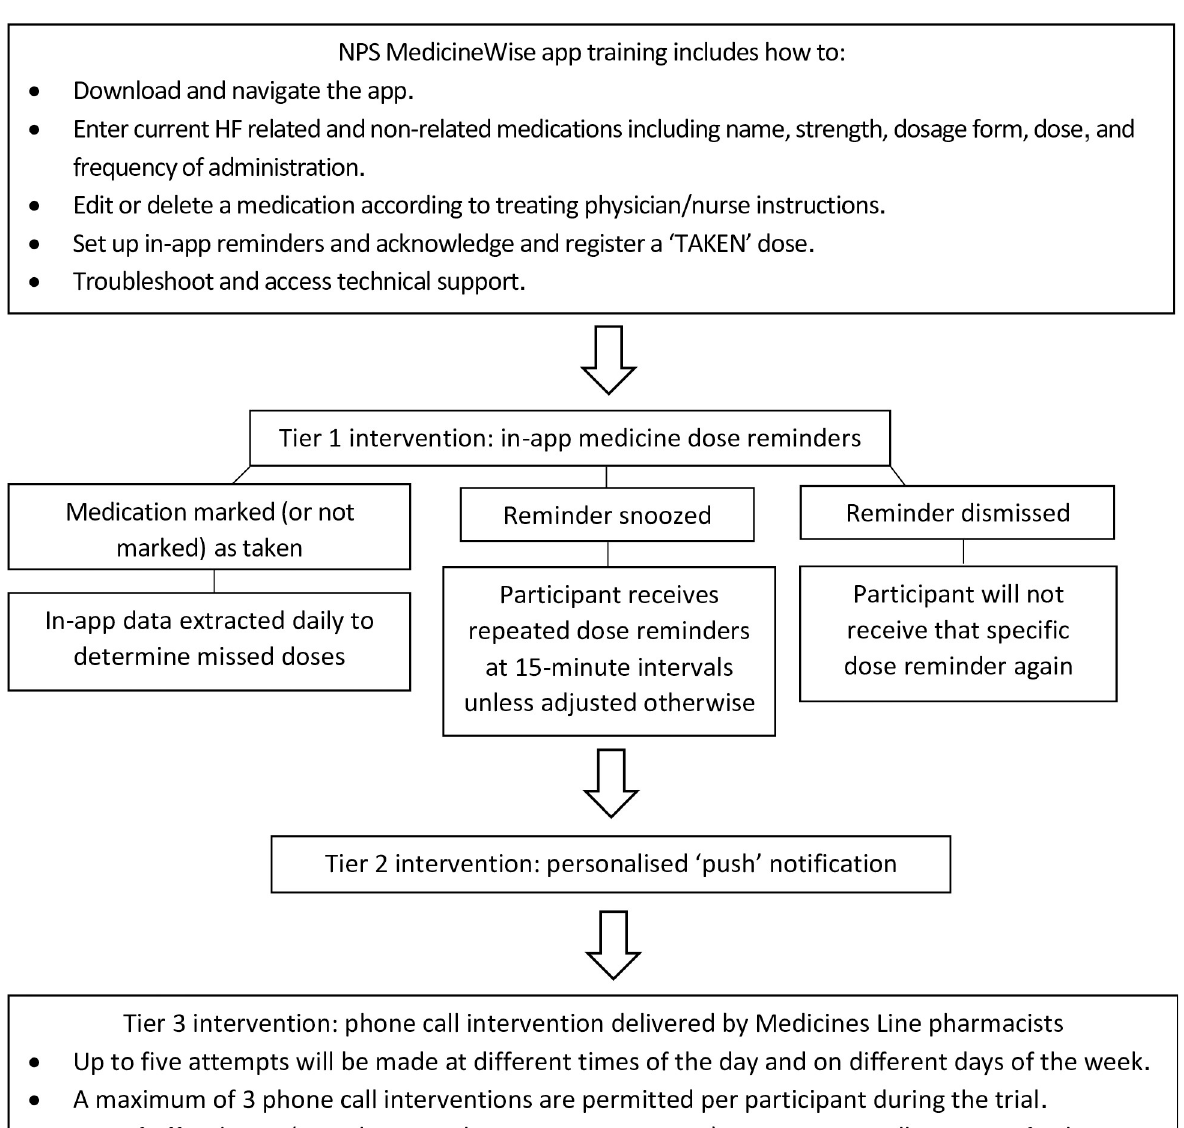
Fig 3. Schematic process of trial